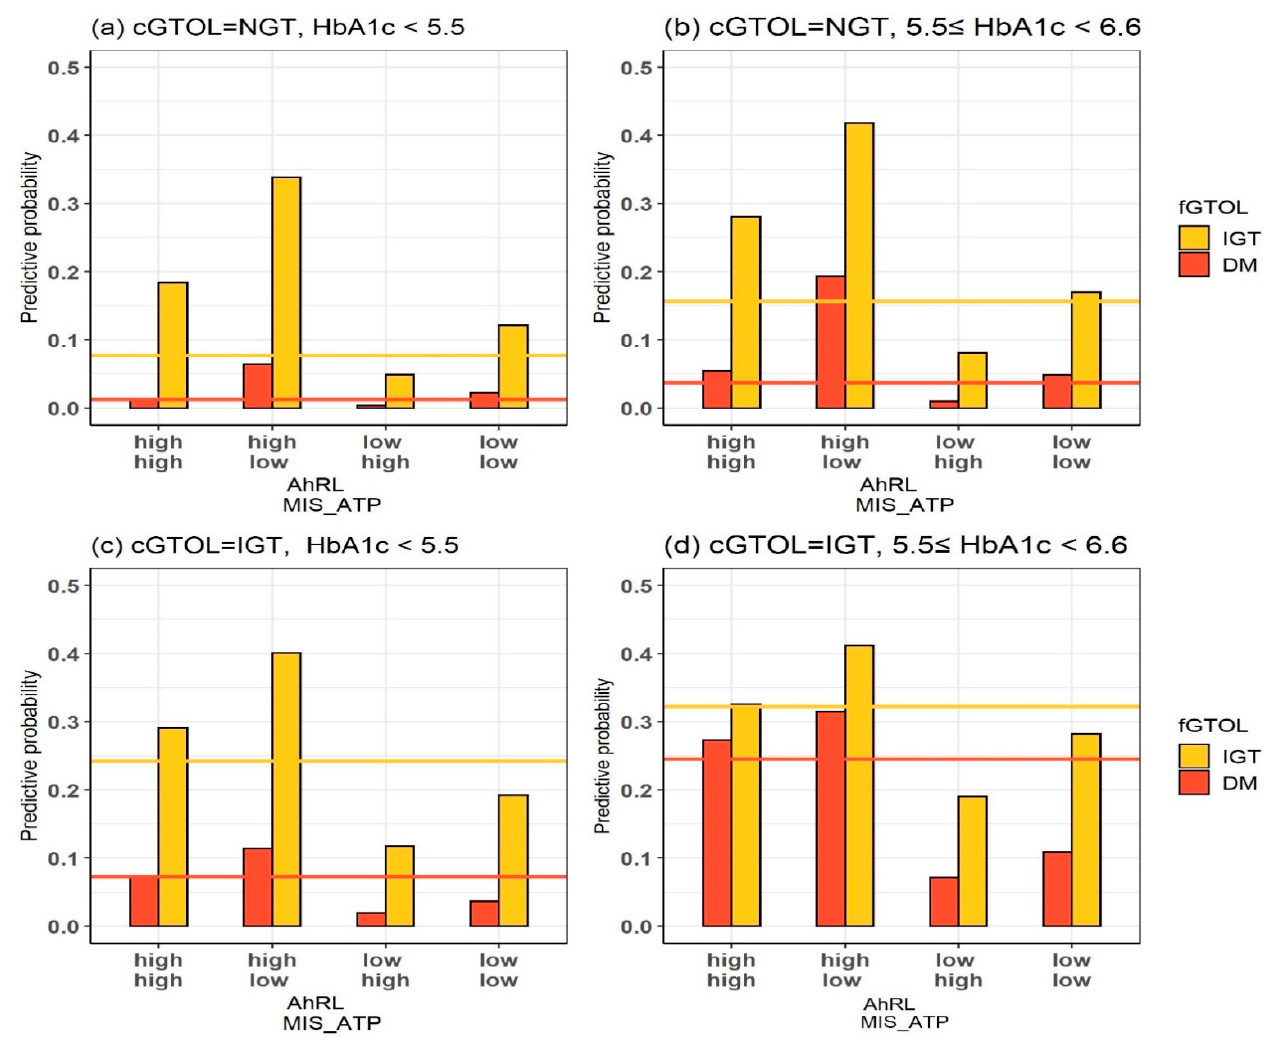
Figure 5. Predictive probabilities of DM (red) and IGT (yellow) for the joint levels of AhRL and MIS-ATP given cGTOL and HbA1c. The levels of AhRL are low (<2.7) and high ( ≥ 2.7), and the levels of MIS-ATP are low (<88.07) and high ( ≥ 88.07). The lines in each figure show the predictive probabilities of DM (red) and IGT (yellow), marginalized over AhRL and MIS ‐ ATP.